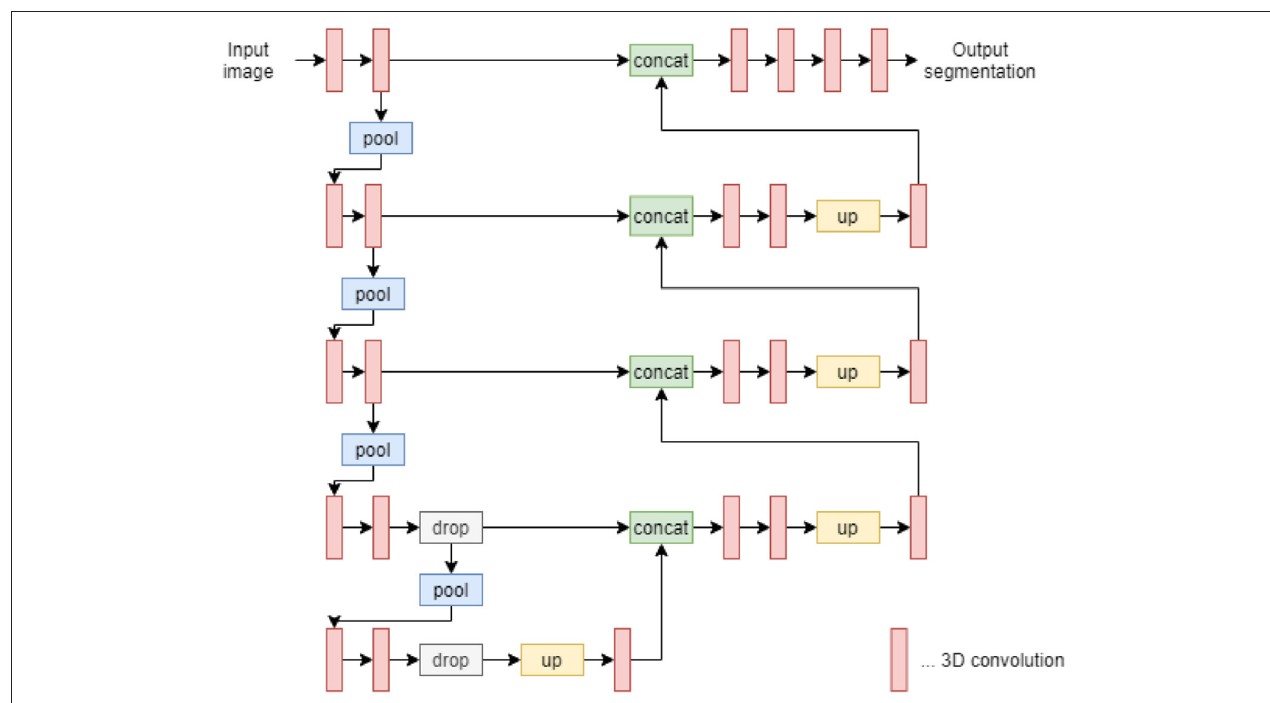
FIGURE 2 | U-Net 3D architecture